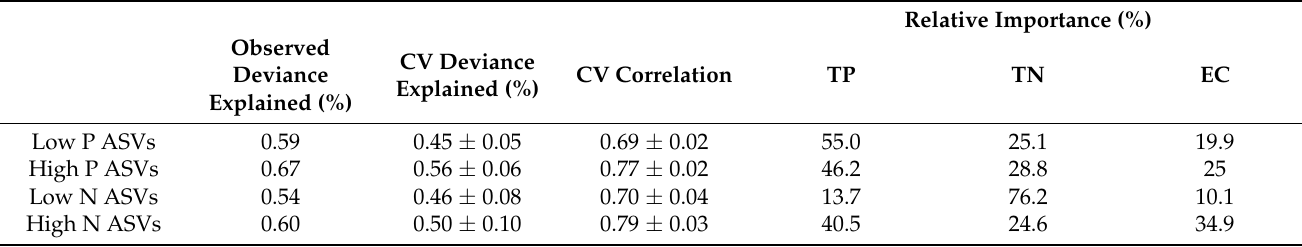
Table 4. Results from boosted regression tree models for each bacterial metric showing deviance explained as a percentage of the null deviance for observed data and of deviance explained using cross-validated (CV) data. EC = electrical